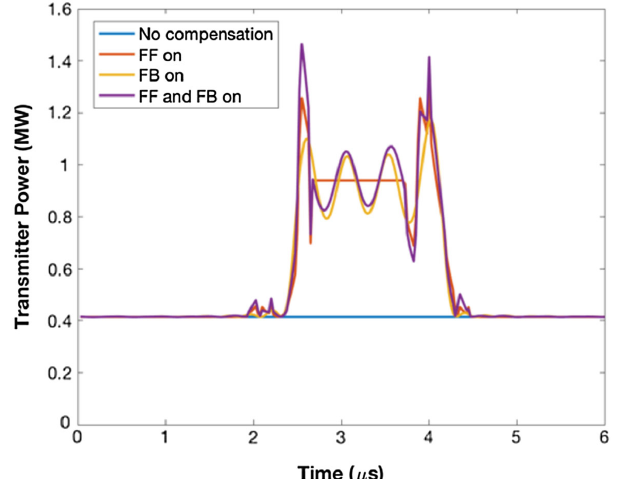
FIG. 8. Transmitter power for three-section cavity.